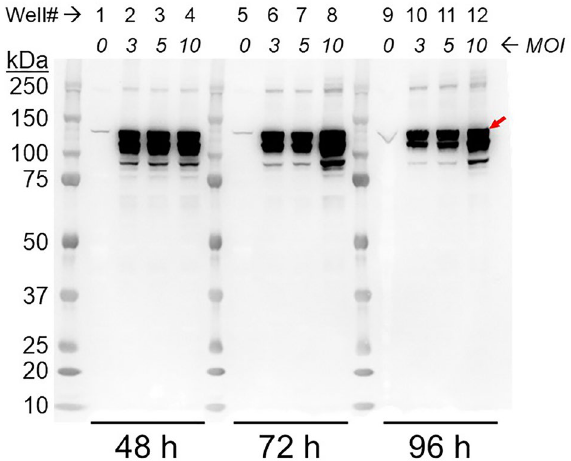
Figure 1. Optimization of pGC-A expression in Sf9 cells. Western blot (anti-pGC-A) of total cell protein over different virus multiplicities of infection (MOI) and transfection time. MOI of 0 indicates no virus transfection. pGC-A (red arrow) is approximately 120 kDa.